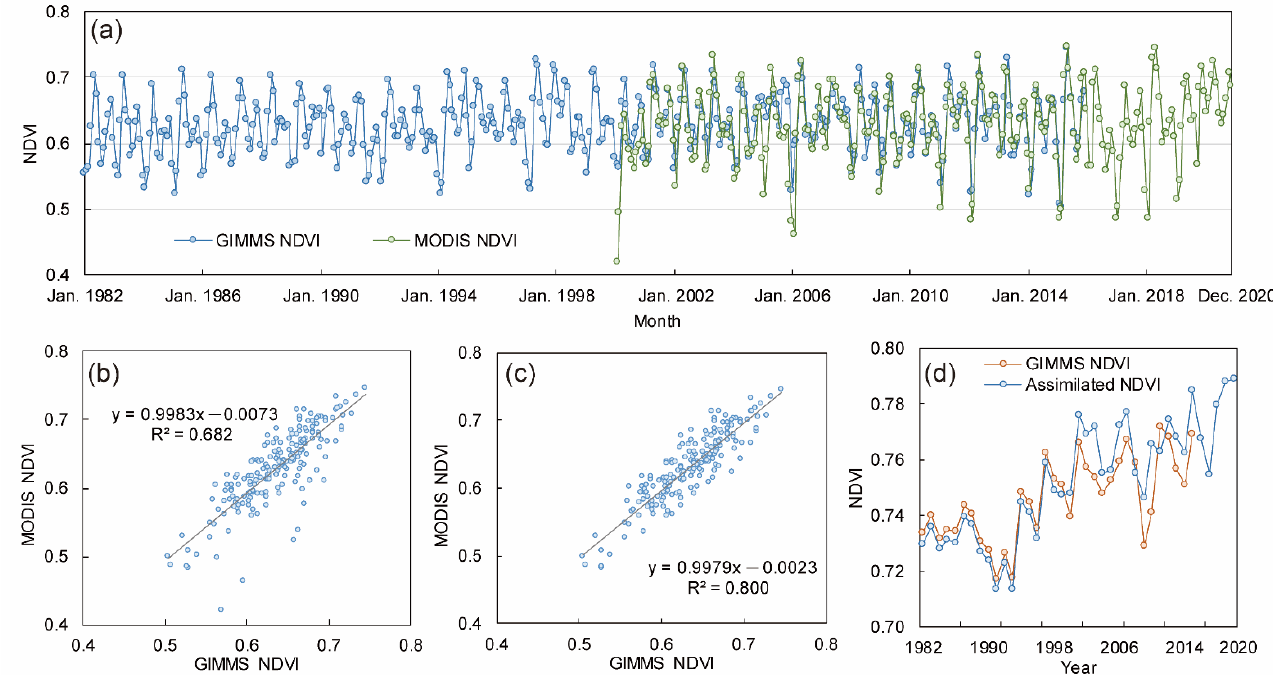
Figure 2. NDVI time series from GIMMS and MODIS. ( a ) Monthly NDVI time series from 1982–2020. ( b ) Correlations of the two datasets for 2000–2015. ( c ) Correlations of the two datasets for 2000–2015 without singular values and extreme values. ( d ) Assimilated NDVI for 1982–2020.